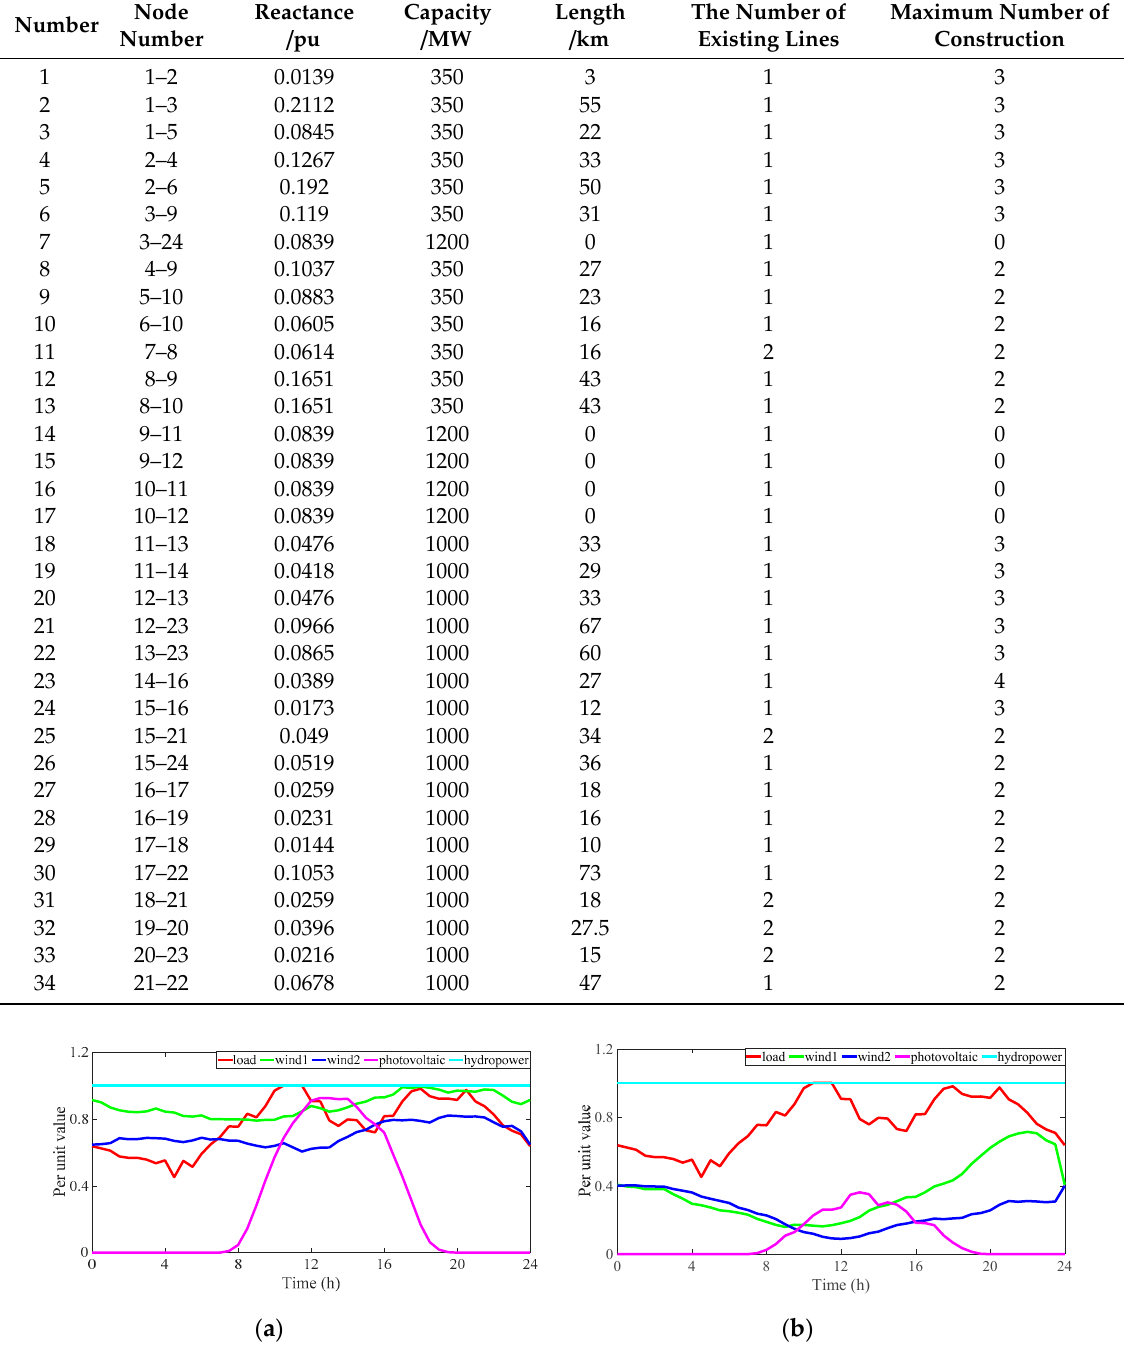
Table A6. IEEE RTS-24 system line data.